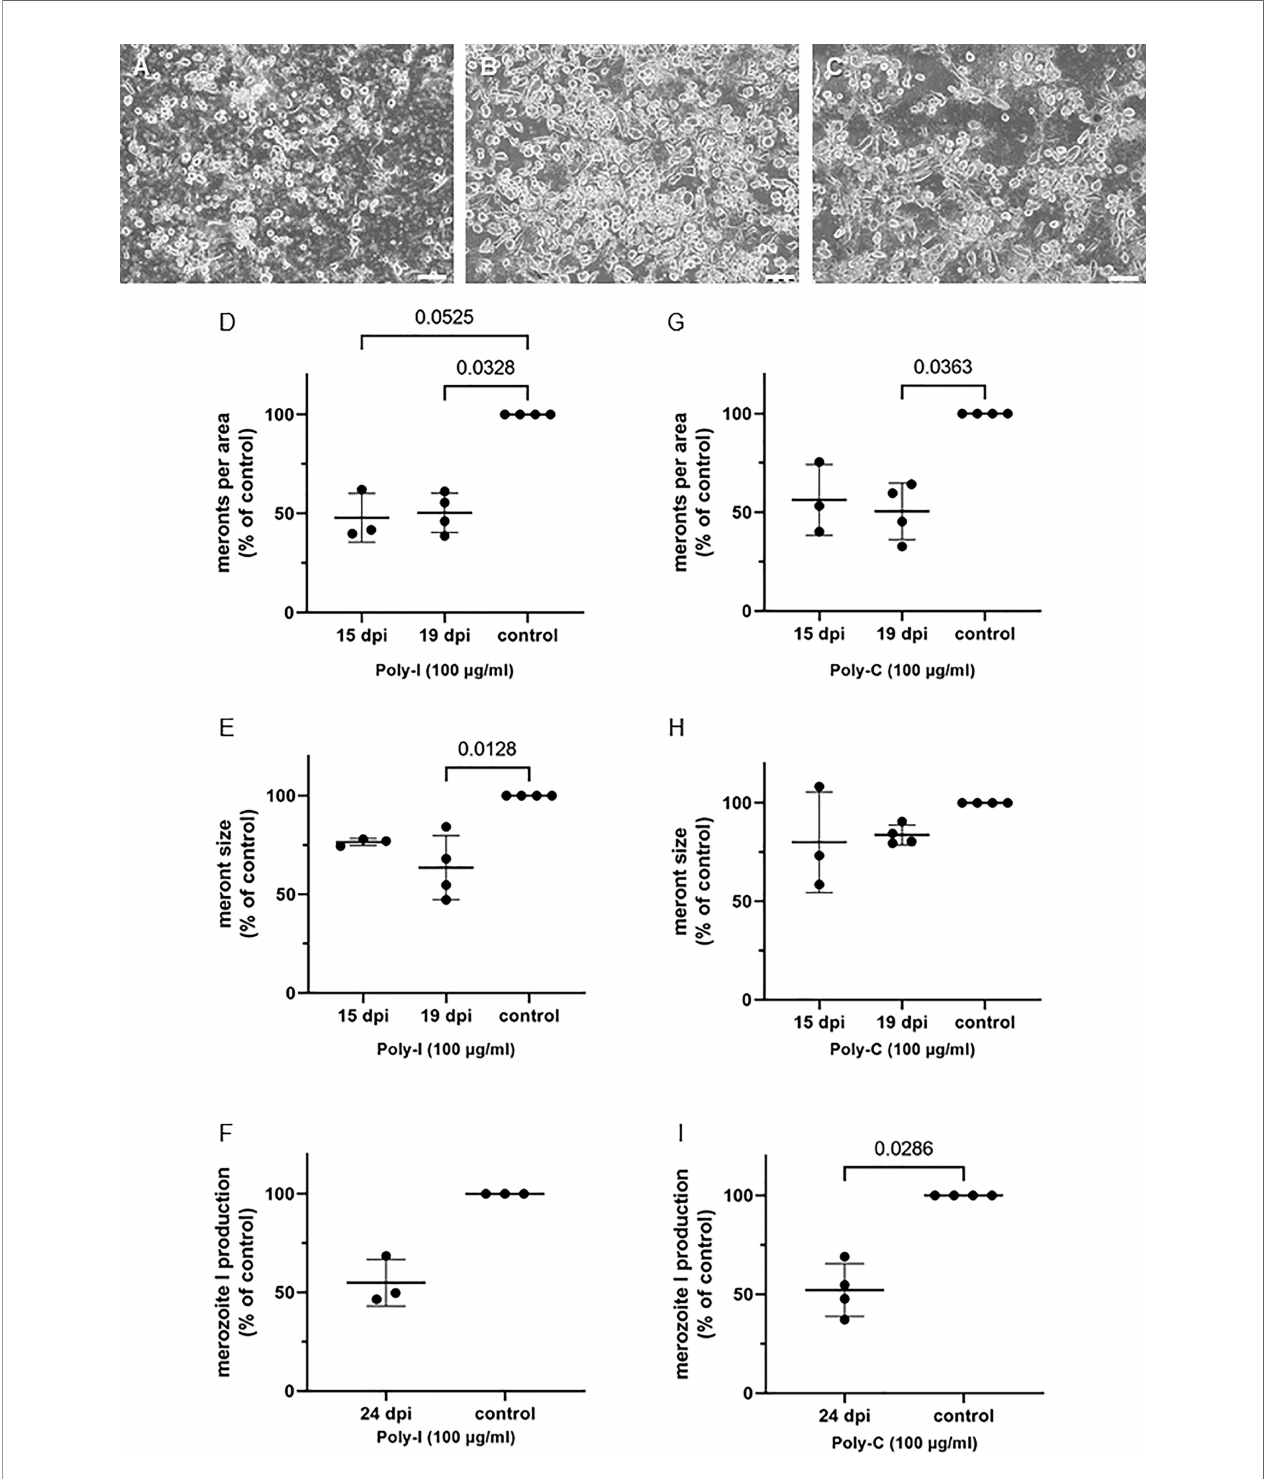
FIGURE 6 | Poly-I (polyinosinic acid) and Poly-C (polycytidic acid) treatments reduce E. bovis replication. (A) Poly-I treated-, (B) control- and (C) Poly-C treated- E. bovis -infected BUVEC (3-4 biological replicates with technical duplicates) at day 19 p. i. Number of meronts I (D, G) and meront I size (E, H) were calculated at 15 and 19 d p. i., and merozoite I production (F, I) was determined at 24 d p. i. Results are expressed as percentage of untreated controls (100%). Scale bar 200